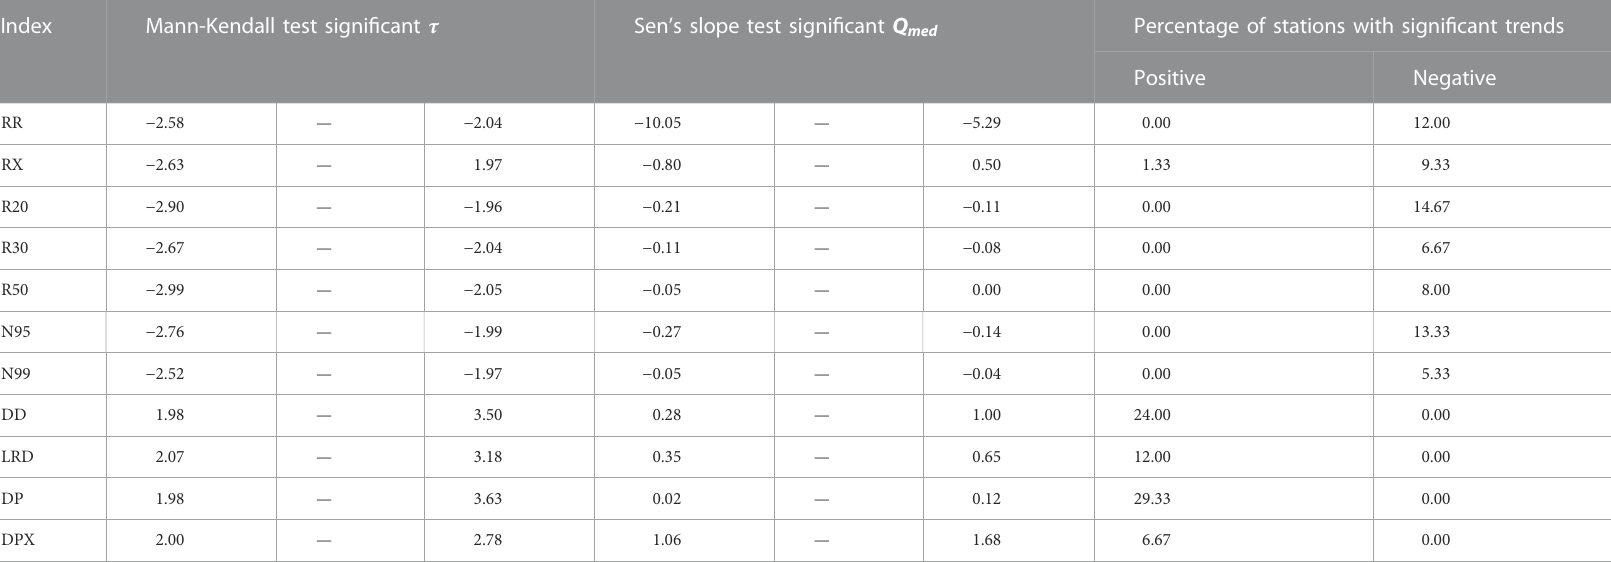
TABLE 2 Mann-Kendall ( τ ) and Sen ’ s slope estimator ( Q med ) tests results at the 5% signi fi cant level and the percentage of stations with signi fi cant trends for the precipitation indices in the annual time scales from 1974 to